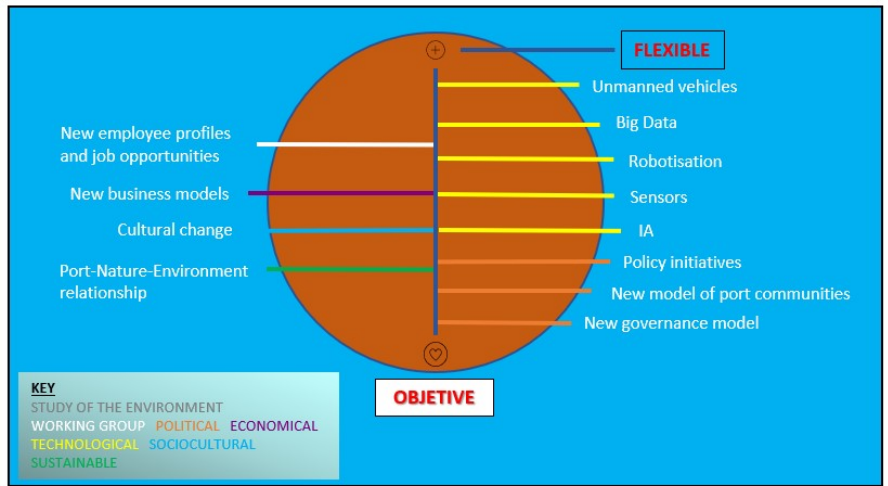
Figure 19. Flexible port elements. Source: own elaboration. Connected ports will primarily need indicators from the technology block, as would be expected, in addition to indicators such as providing access to the Internet in more remote locations to make it accessible and the shift from competition to collaboration. In the working group block, social networks and apps stand out.